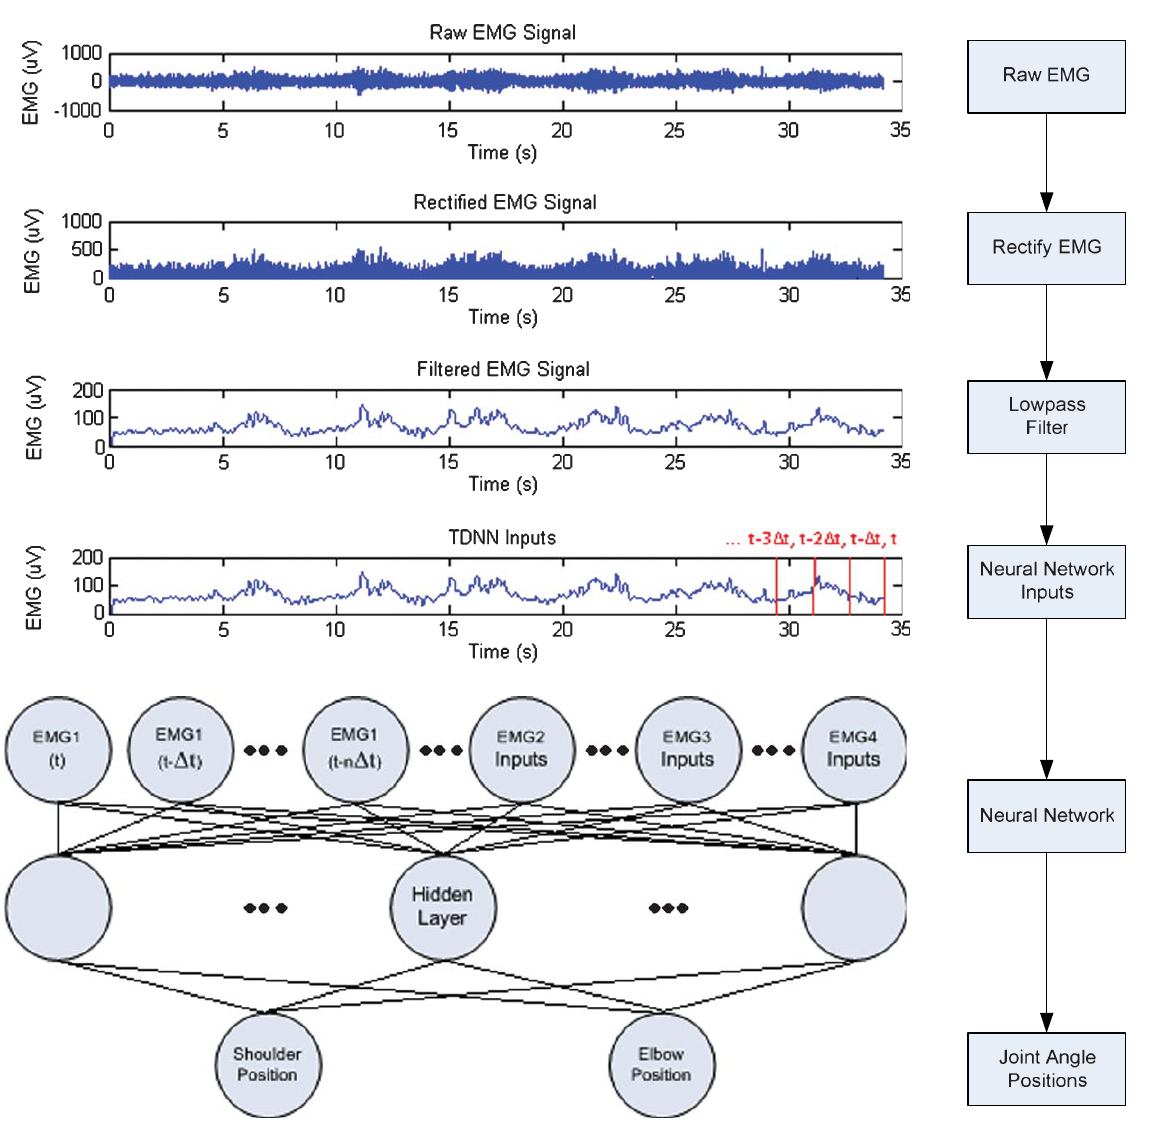
Fig. 2. Proposed joint tracking myoelectric control scheme using a